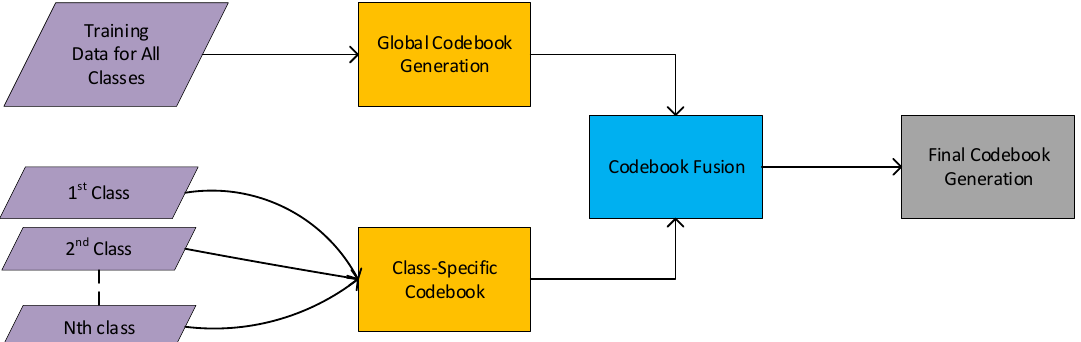
Figure 2. Agglomerative clustering for codebook